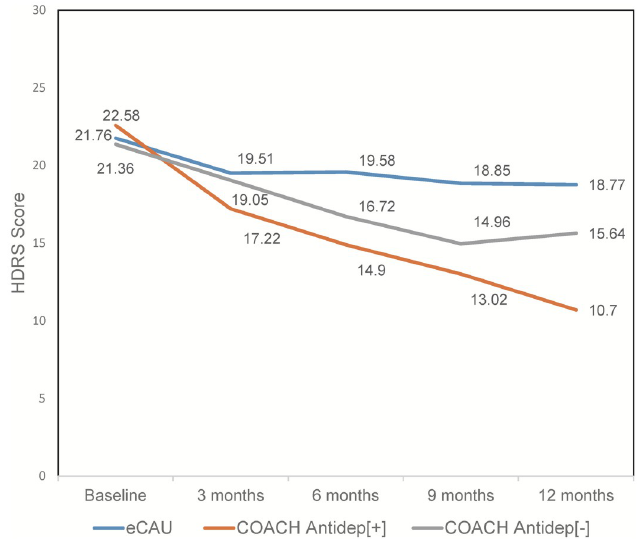
Fig 2. Depressive symptom severity over 12 months of 3 groups of participants. eCAU, COACH participants who accepted antidepressant medications (Antidep[+]), and COACH participants who declined antidepressant medications (Antidep[ − ]). COACH, Chinese Older Adult Collaborations in Health; eCAU, enhanced care-as-usual; HDRS, Hamilton Depression Rating Scale.